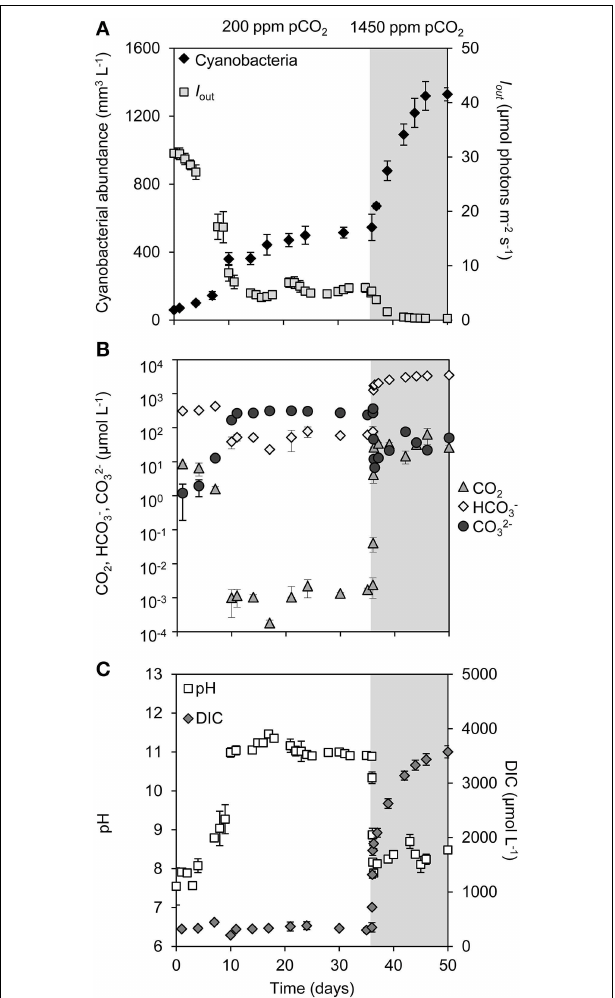
FIGURE 1 | Changes in cyanobacterial abundance, light, dissolved inorganic carbon (DIC) and pH during a shift from low pCO 2 (200 ppm, white area ) to high pCO 2 (1450ppm, shaded area ). (A) Cyanobacterial abundance (expressed as biovolume) and light intensity penetrating through the chemostat ( I out ). (B) Dissolved CO 2 (dCO 2 ), bicarbonate (HCO − 3 ) and carbonate (CO 2 − 3 ) concentrations (logarithmic scale). (C) Dissolved inorganic carbon (DIC) and pH. Error bars indicate standard deviations ( n = 4